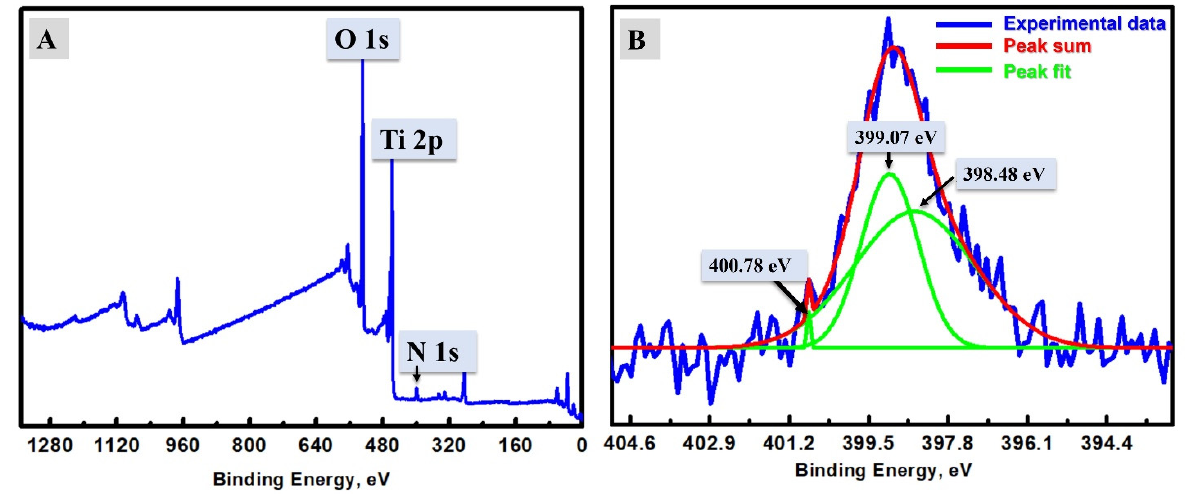
Figure 4. ( A ) XPS analysis of N-Titania; ( B ) XPS fine spectrum of the N-Titania in the region of nitrogen.